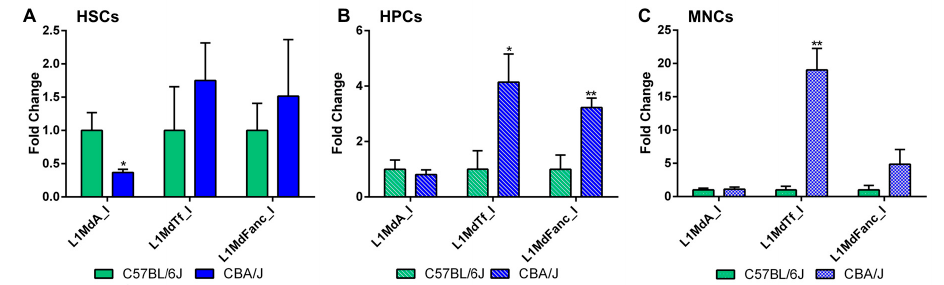
Figure 3. Comparative analysis of expression of three evolutionary distinct LINE-1 elements in the hematopoietic system of C57BL/6J and CBA/J mice: L1MdA_I (0.21 Million years, Myr); L1MdTf_I (0.25 Myr), an L1MdFanc_I (6.80 Myr). The differential expression of LINE-1 elements was